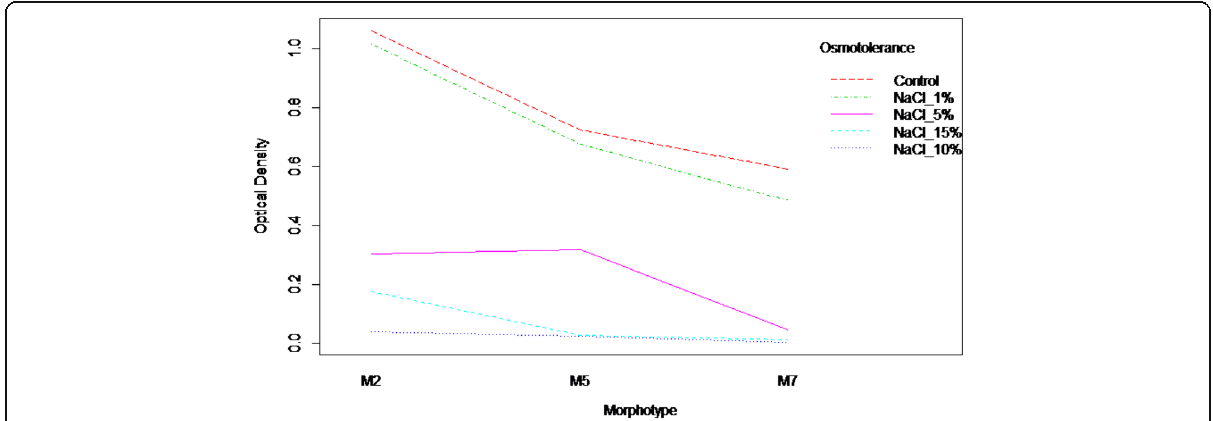
Fig. 4 Growth of antagonistic yeast morphotypes: M2, M5 and M7, under different NaCl concentrations. Growth was measured by optical density at 540 nm after 48 h under the evaluated concentration. The two-way ANOVA indicated highly significant effects for concentration ( F = 225.22; P < 0.05; df = 4) and morphotype ( F = 60.05; P < 0.05; df = 2) and a significant interaction effect ( F = 7.84; P = 0.000012; df =